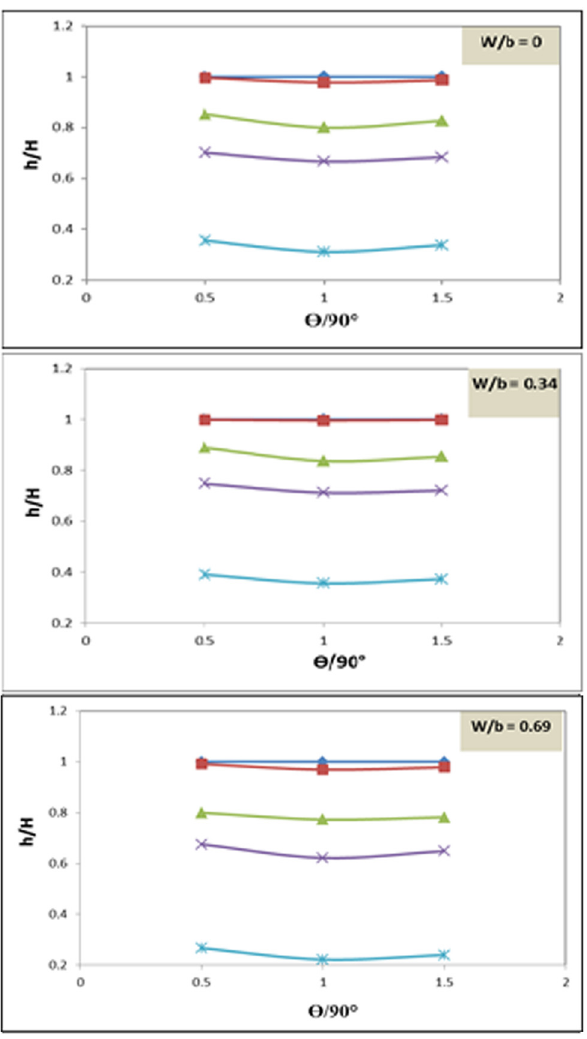
Figure 4: E ff ect of cuto ff angle on head pressure for di ff erent points at fl ow line.